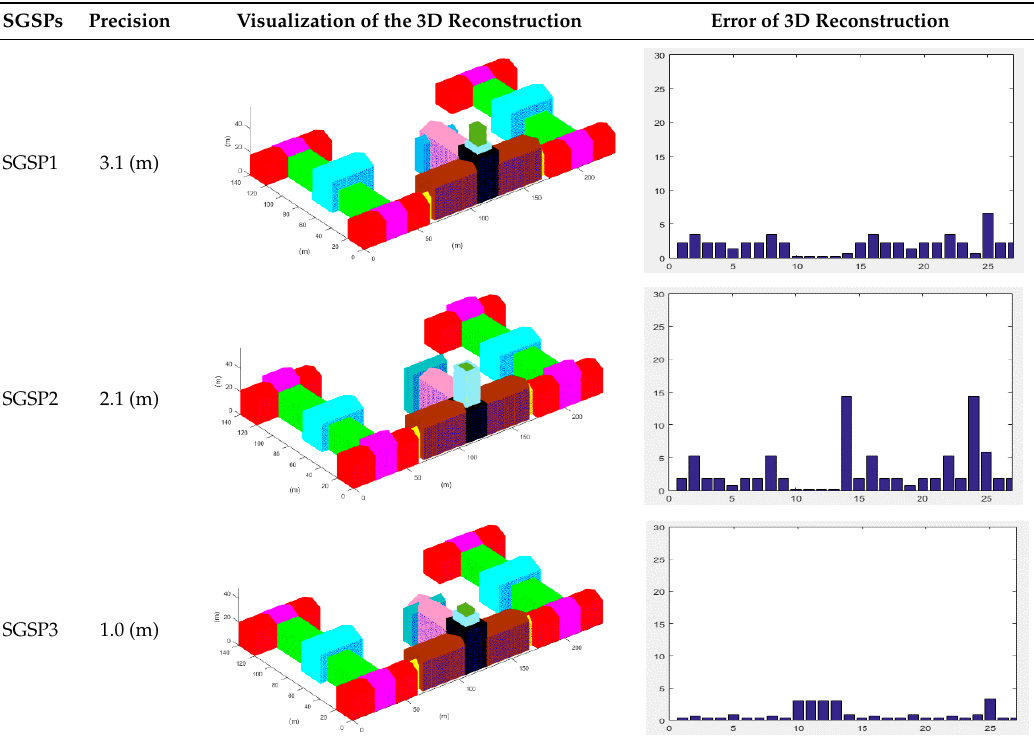
Table 5. Reconstruction results obtained by different SGSPs. “Precision” is the mean PRE of the 27 basic-unit-models. Figures in the last column show the error of 3D reconstruction; the x -axis is the serial number of units, and the y -axis is PRE (unit: m).